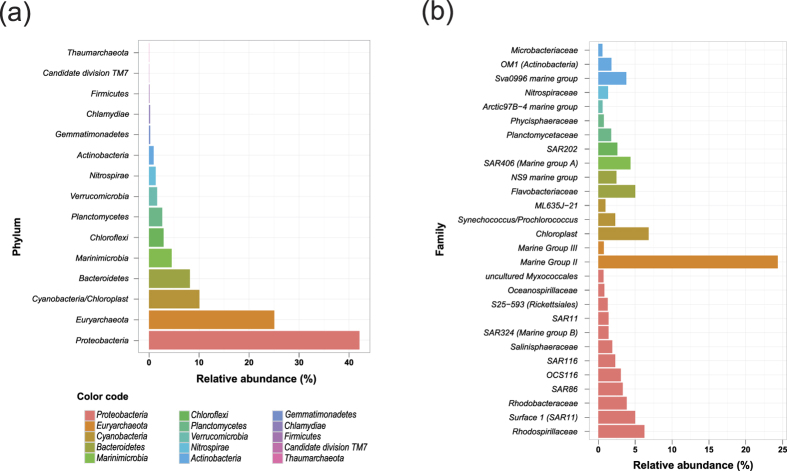
Relative abundance of microbial taxa determined by 16S amplicon sequencing.Abundances are reported as percent of the total count of merged MiSeq reads. 16S sequences from chloroplasts of eukaryotic phytoplankton were not classified further (SILVA pipeline default). (a) Taxa abundances at phylum level. Only taxa with > 0.01% abundance were considered. (b) Abundances at family or the next available level. Only taxa with > 0.5% abundance were included.